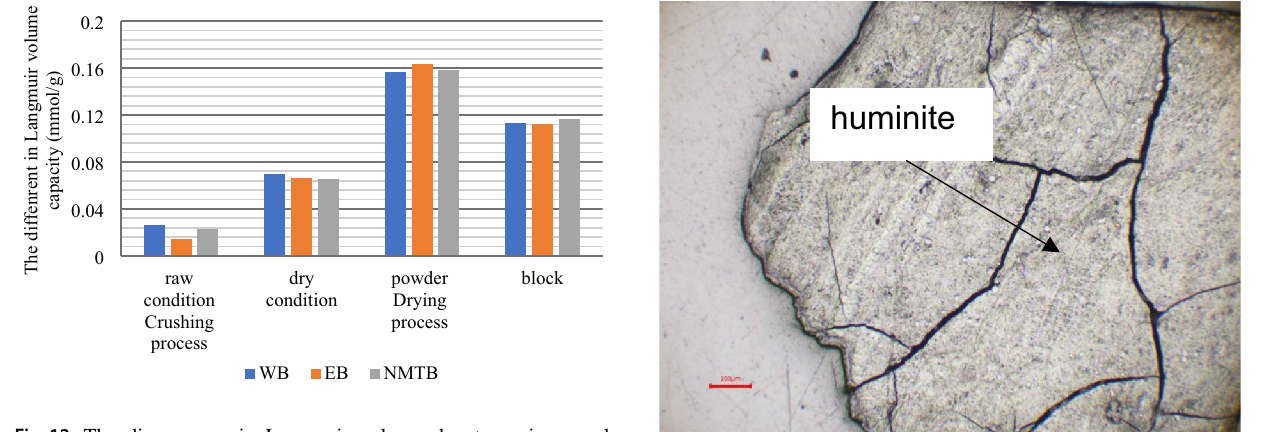
Fig. 12 The discrepancy in Langmuir volume due to various coal conditions